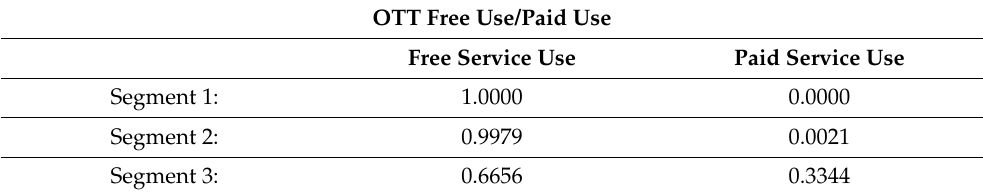
Table 6. Item-response probability by the rate of OTT paid service use.